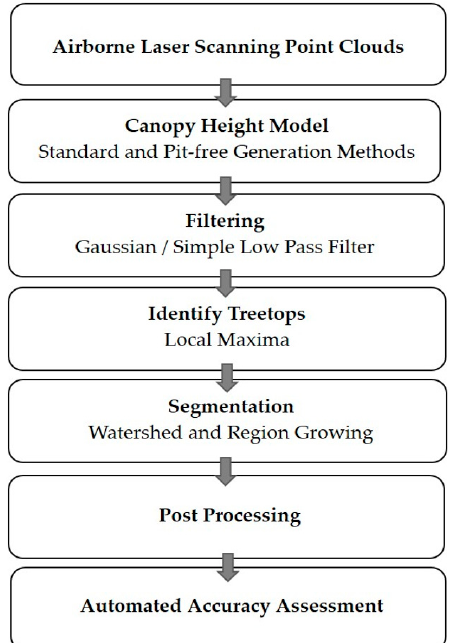
Figure 2. A summary of the data processing tasks required for the implementation of the ITC segmentation methodology.